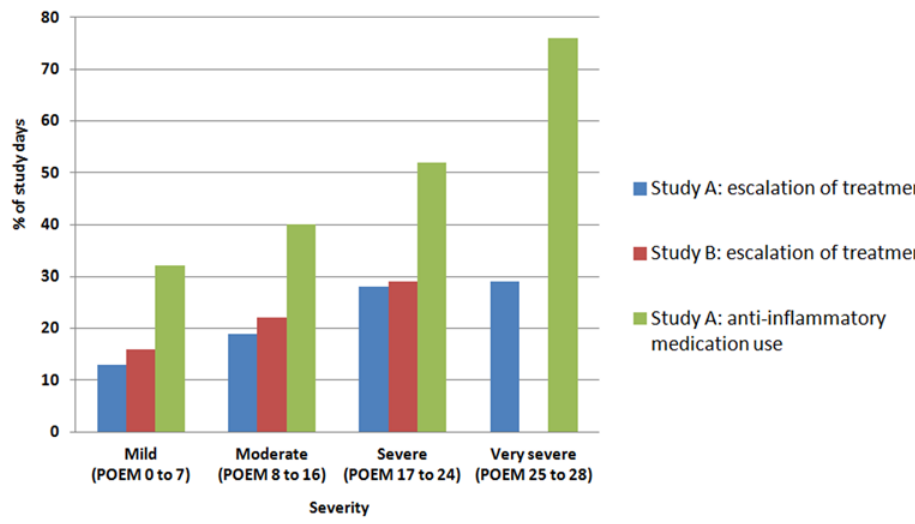
Fig 2. Proportion of days in flare by mean POEM scores for AE